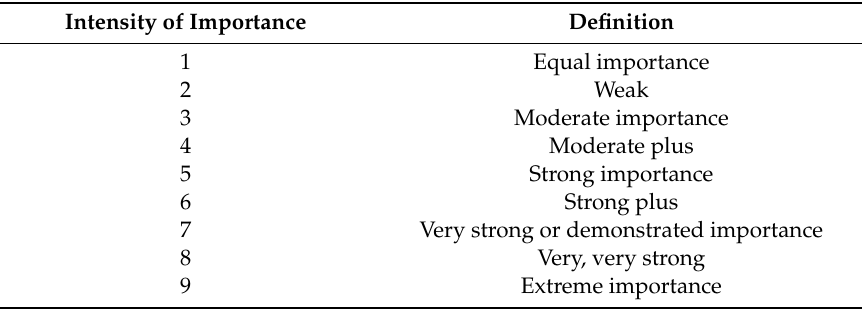
Table 1. The 1 to 9 fundamental